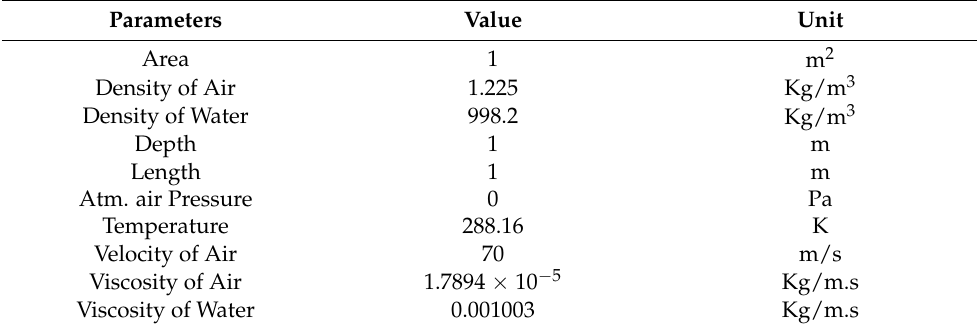
Table 7. Parameters for 2D CFD buoy model in ANSYS